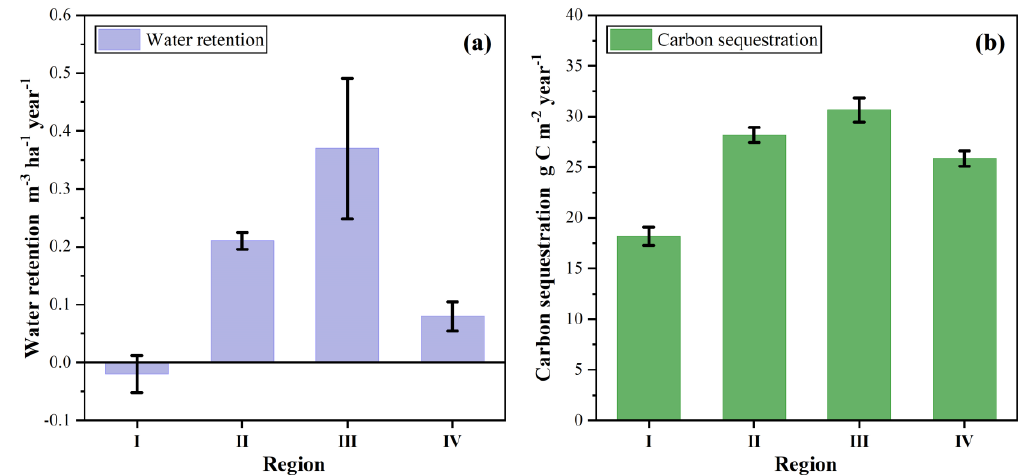
Figure 3. Mean changes (±SE) in the water retention ( a ) and carbon sequestration ( b ) among the four tourism resource development regions from 2000 to 2015 in the Huangshan UNESCO Global